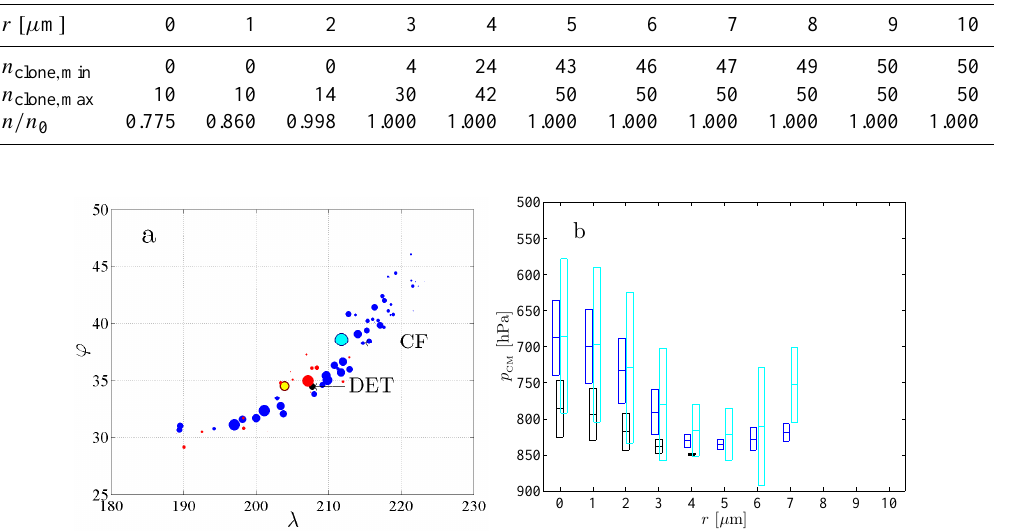
Fig. 8. (a) The horizontal location of the center of mass of the pollutant clouds in the atmosphere (blue) and in the deposition field (red) for the 50 ensemble members after 2.5 days. The radii of the circles are proportional to the standard deviations. DET and CF denote the deterministic forecast (black) and the control forecast, respectively, and the cyan (yellow) dot with dark edge marks the center of mass and standard deviation of all particles of the 50 ensemble members that remain in the atmosphere (deposit). (b) The mean vertical coordinate of the center of mass of the ensemble members (lines in the boxes) with the mean standard deviation (the bottom and the top of the boxes) (blue), and those for the whole ensemble forecast (cyan) and for the deterministic forecast (black).